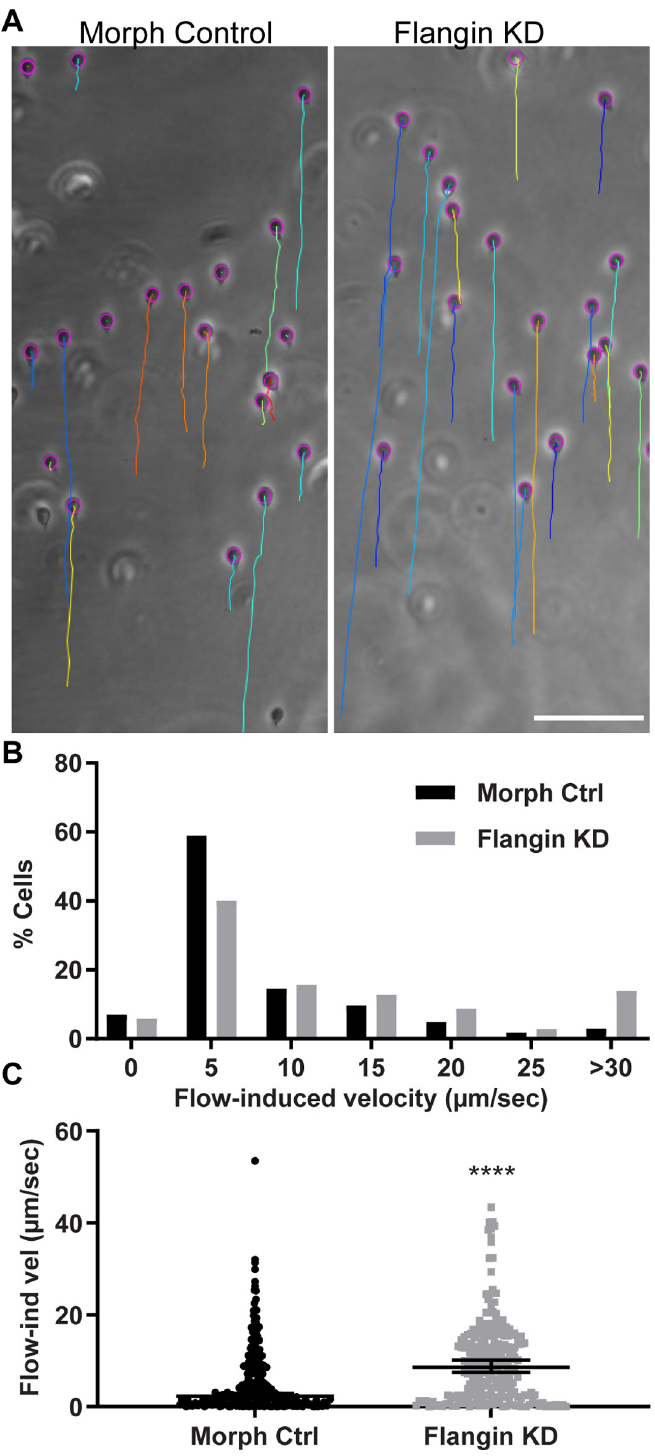
Fig 7. The flange has a role in attachment. (A) Flow chamber assay to test the role of the flange in attachment. A flow rate of 100 μ l/s induced sliding. The paths of cells were followed with TrackMate, the paths at the end of the 10s challenge are indicated by the colored lines. See S9 Movie. (B) Histogram of flow induced velocities for the standard morpholino control n = 268 and anti-Flangin morpholino treated cells n = 248 analyzed from six challenge assays. (C) Plot of measured values where error bars are median with 95% confidence interval; statistical significance determined with a Mann-Whitney U test. ���� , P < 0.0001. Scale bar = 100 μ m. https://doi.org/10.1371/journal.ppat.1010496.g007 PLOS Pathogens| https://doi.org/10.1371/journal.ppat.1010496 April 28,